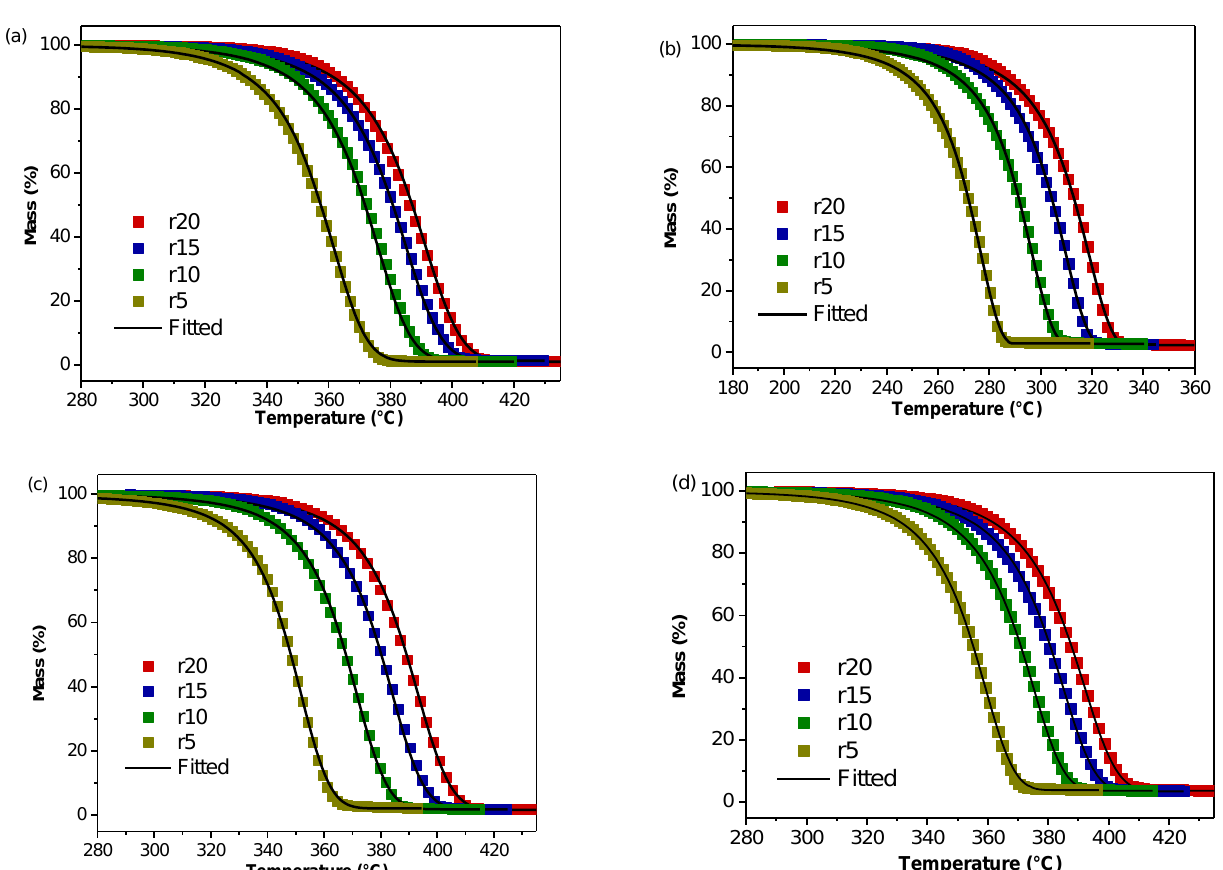
Figure 9. Mass (%) curves and the corresponding fitting curves of ( a ) neat PLA, ( b ) PLA ZnO, ( c ) PLA Ag, and ( d ) PLA TiO 2 at various heating rates. Table 3. Activation energy, pre-exponential factor, and reaction order of neat PLA and PLA